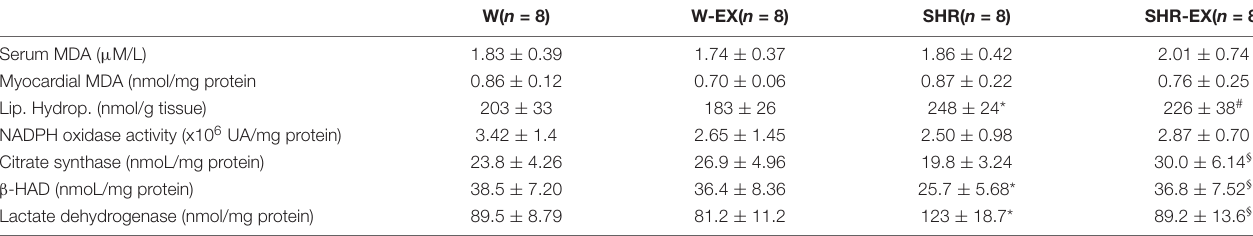
TABLE 7 | Oxidative stress and energy metabolism.